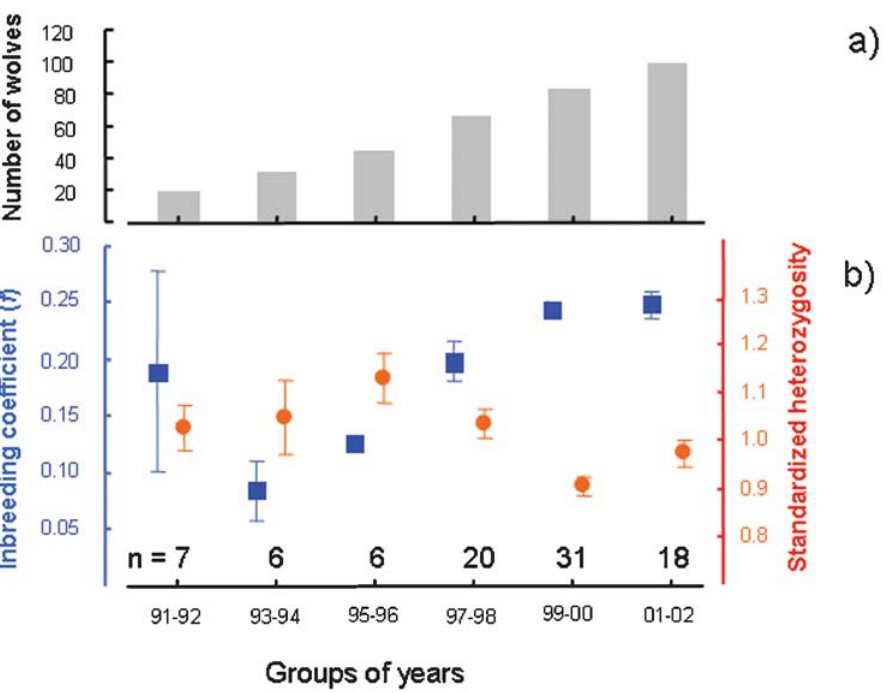
Figure 1. Demographic and genetic data for the Scandinavian wolf population between 1991 and 2002 averaged over two-year periods. a) mean number of wolves and b) mean ( 6 s.e.m.) inbreeding coefficients (blue) and standardized heterozygosity (red). The number of genotyped wolves ( n ) per group of years is indicted above the X-axis. Both inbreeding coefficients ( F 5,82 =5.95, P , 0.001) and standardized heterozygosity ( F 5,82 =4.97, P , 0.001) show significant differences among the groups of